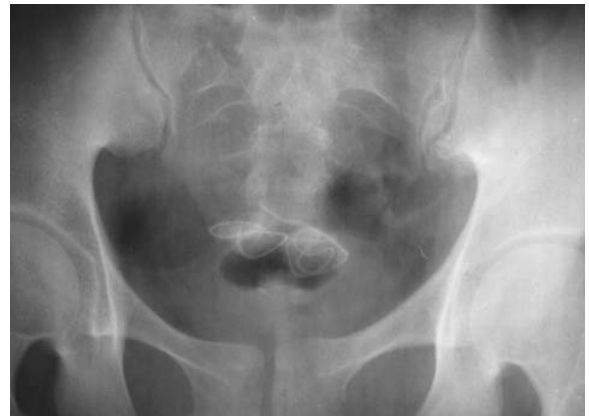
Figure 3 – X-ray of the pelvis showing coiled up wire in the urinary